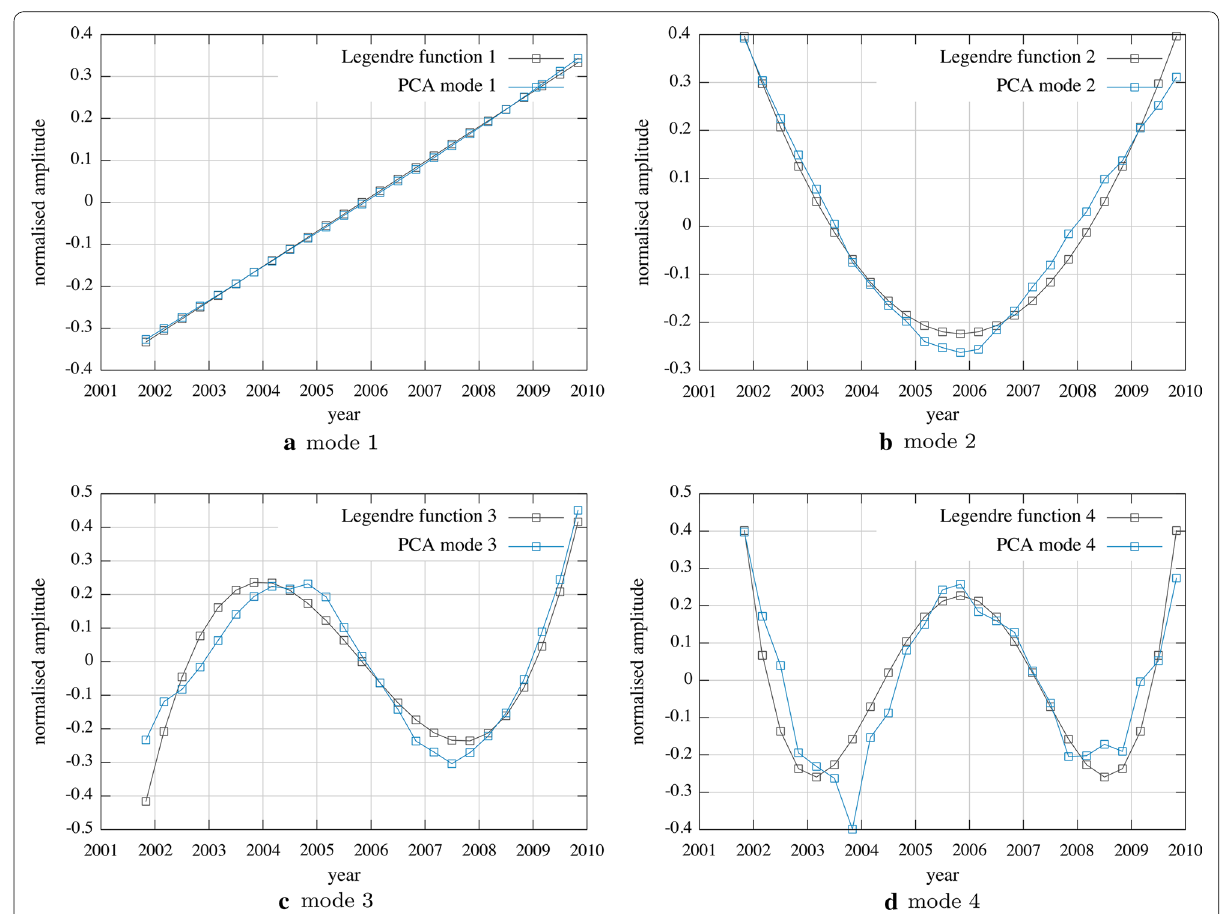
Fig. 1 Normalised time series y ′ j [see Eq. (2)] corresponding to the first four modes from CHAMP, in blue, and corresponding normalised Legendre polynomials, in